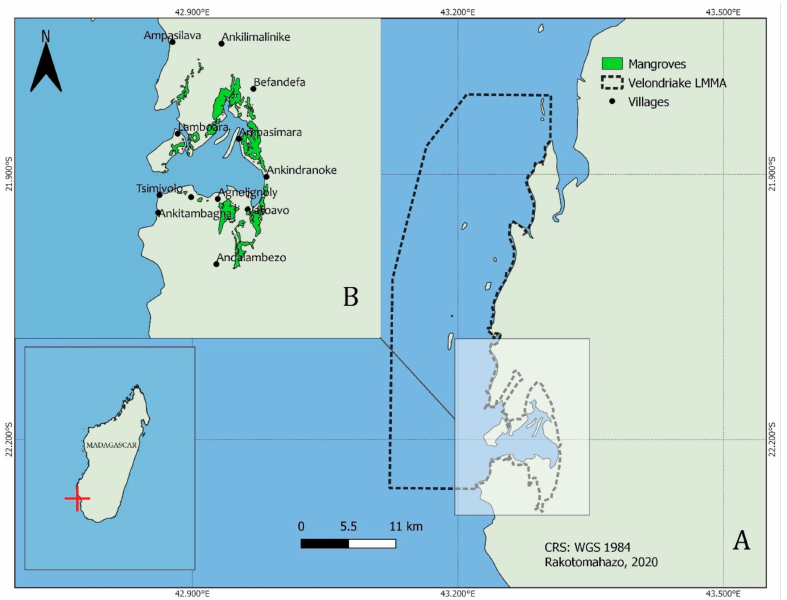
Figure 1. Map of the study site showing the Velondriake LMMA ( A ) and the Baie des Assassins with its mangrove coverage and villages ( B